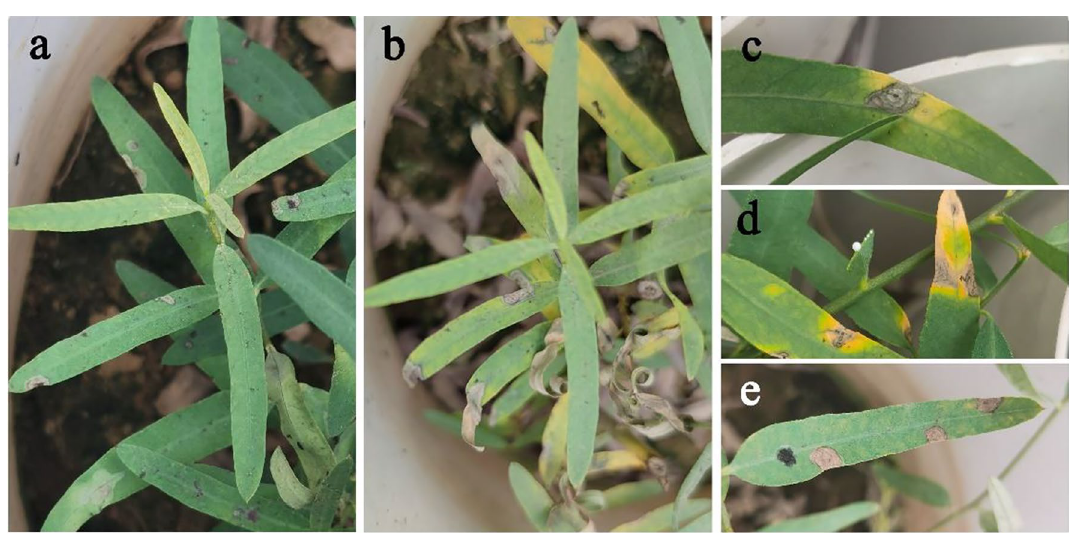
Figure 10. The symptoms of leaves necrotic lesions disease in inoculated leaves of Luobuma. ( a ) leaf symptoms of A. venetum 5 days after inoculation, ( b ) leaf symptoms of A. venetum 13 days after inoculation, ( c,d ) the clear wheel disease spots on the leaves of P. hendersonni and ( e ) unclear wheel disease spots on the leaves of A. venetum and P. pictum